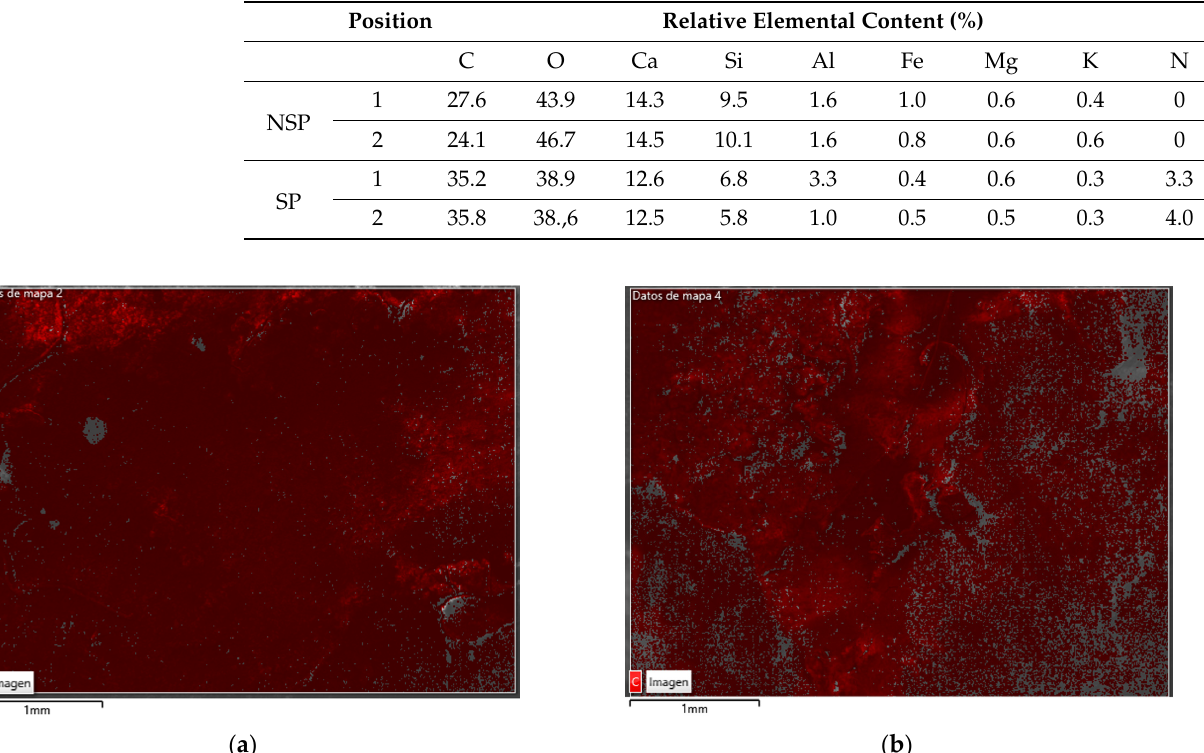
Figure 4. Secondary electron image made with SEM, with a layer superimposed with the carbon distribution of regions 2 SP ( a ) and 1 NSP ( b ).